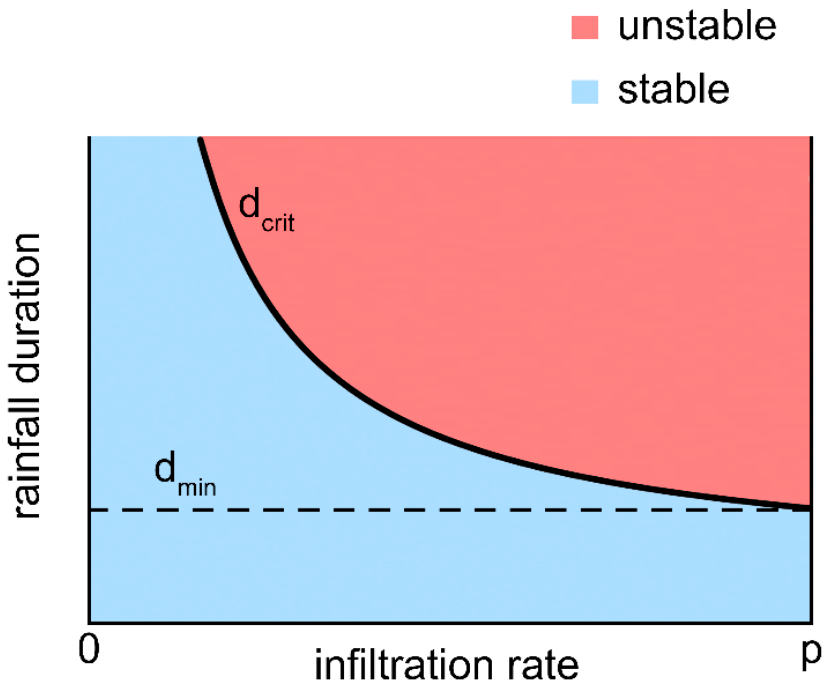
Figure 3. Example of a critical curve defining the precipitations capable of triggering a shallow landslide at a given depth.